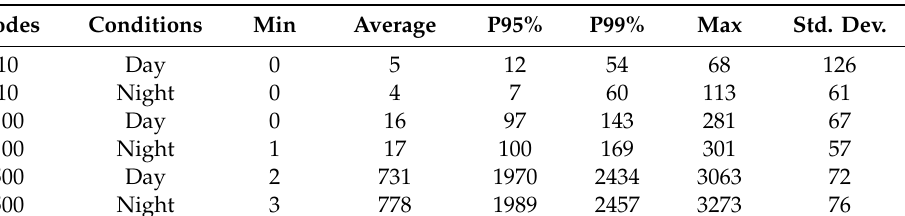
Table 7. Statistics of the D RL (delay introduced by the rate limiter block) collected in the scalability experiments. All values are in milliseconds.